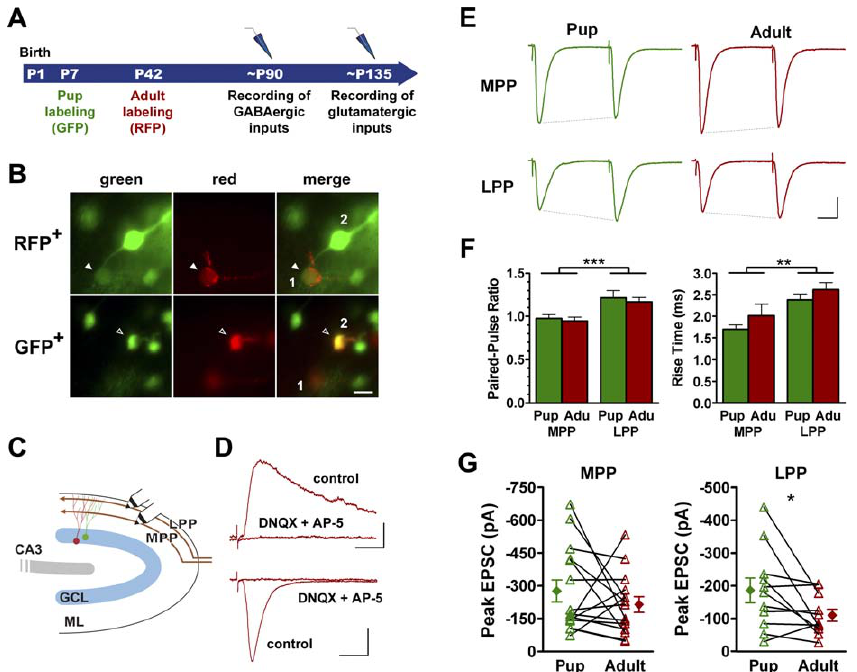
Figure 2. Entorhinal Glutamatergic Afferents onto Mature Neurons Generated in the Developing and Adult Hippocampus (A) Schematic diagram of experimental design for retroviral labeling and electrophysiological recordings. (B) A paired experiment. Upper row: a RFP þ neuron was patched (cell ‘‘ 1 ’’ ) and filled with Alexa Fluor 488 (green). Lower row: a neighboring GFP þ neuron (cell ‘‘ 2 ’’ ) was subsequently patched and filled with Alexa Fluor 594 (red). Both DGCs are in the same field, although at different focal planes (see merge channel). At the end of the experiment, both cells display green and red fluorescence (merge). Scale bar indicates 10 l m. (C) Schematic diagram of the DG showing the position of the bipolar electrodes for the stimulation of the MPP and LPP. (D) Example of EPSCs from an adult-born DGC at V hold ¼þ 50 mV (top) and (cid:2) 80 mV (bottom) elicited by LPP stimulation recorded in the presence of vehicle ( ‘‘ control ’’ ) or 20 l M DNQX þ 100 l M AP-5. Scale bars indicate 20 ms, 40 pA (top) or 20 pA (bottom). Similar properties were observed in DGCs born during development (unpublished data) (E) Example of a paired experiment. Sequential recordings of two neighboring pup and adult DGCs in response to paired-pulse stimulation (100-ms interval) of the MPP and LPP. Scale bars represent 25 ms, 50 pA. (F) Paired-pulse ratio (left) and 20%–80% rise time (right) of EPSCs recorded from pup and adult DGCs upon stimulation of MPP and LPP ( n ¼ 11 to 15) Paired-pulse ratio was measured as the ratio between the amplitude of the second pulse over the first. Two-way analysis of variance (ANOVA) revealed a significant effect of MPP versus LPP for paired-pulse ratio ( p ¼ 0.0002) and rise time ( p ¼ 0.0017), but no significant effect of pup versus adult (Adu) for either parameter. (G) Peak EPSC amplitude recorded in paired experiments from DGCs born during development (Pup) and adulthood (Adult) upon stimulation of the MPP ( n ¼ 15 pairs, p ¼ 0.3, paired t -test) or LPP ( n ¼ 11 pairs, p ¼ 0.049). Mean 6 SEM is shown on the sides. Recordings were carried out in the presence of 20 l M BMI in slices obtained from mice aged 19–21 wk. Neurons were approximately 18 wk old (P7) and approximately 13 wk old (P42). All plots depict mean 6